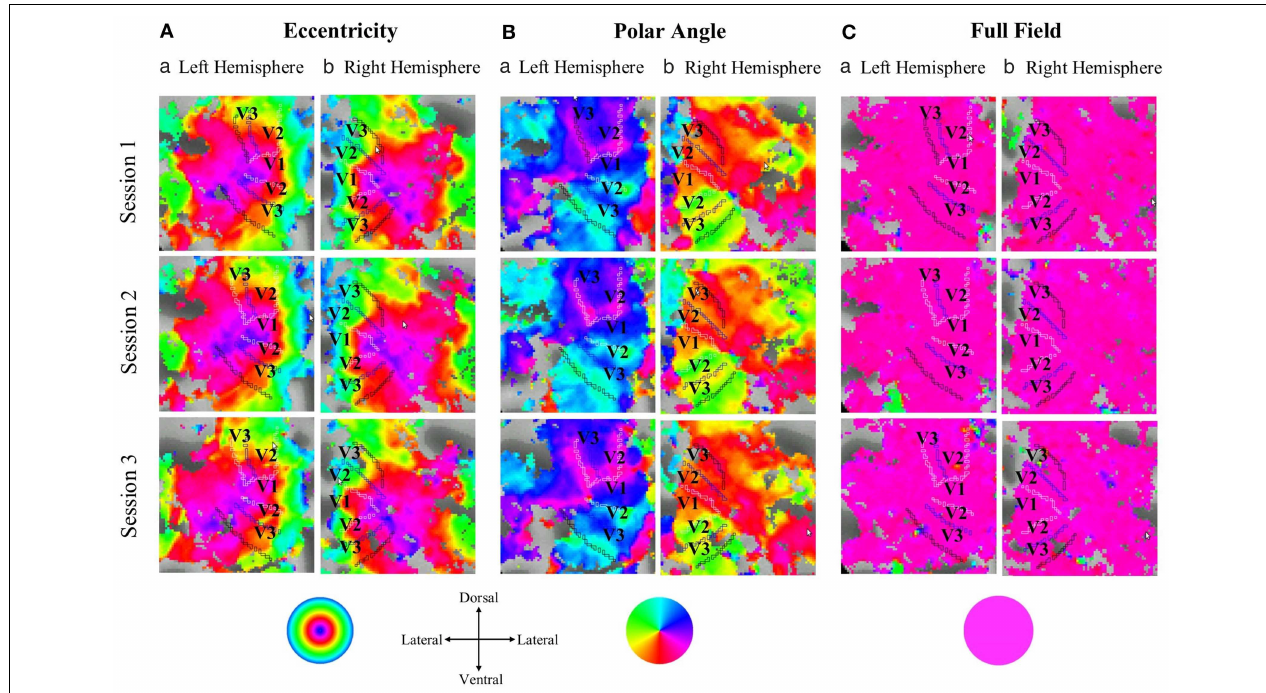
FIGURE 1 | Projection of the response phases onto the flattened representation of the occipital pole for the left and right hemisphere of a single representative subject during (A) eccentricity mapping, (B) polar angle mapping, and (C) full field stimulation (response threshold: p = 0 . 05 ). Typical eccentricity and polar angle maps were evident that covered the cortical expand activated during full field stimulation. There is a high degree of correspondence for the topographies across the three sessions within each stimulation condition.